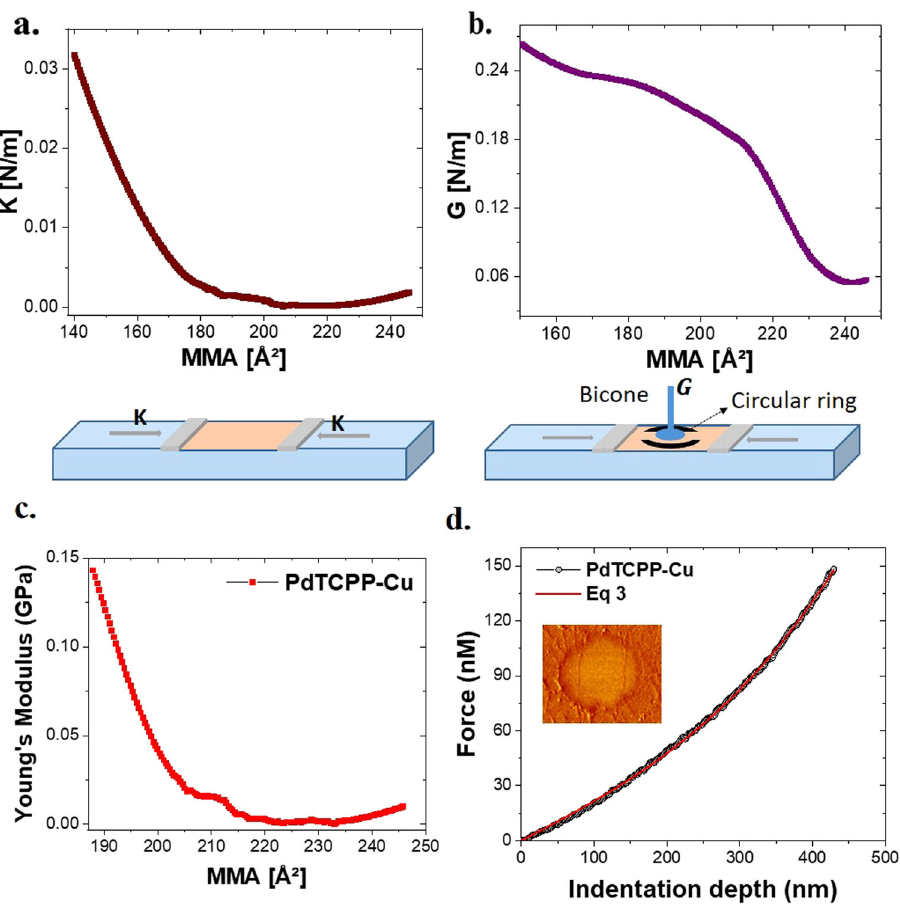
Fig. 3 Mechanical moduli determined by the Langmuir technique and nano-indentation. a The 2D compression modulus of the PdTCPP-Cu monolayer was obtained by measuring the π -MMA isotherm as the monolayer is compressed to a preset pressure. b The interfacial shear storage modulus G ’ was measured using a biconical disk rheometer positioned in the interface. c The Young ’ s modulus of the PdTCPP-Cu monolayer was calculated from G and K . d AFM nanoindentation-based loading/unloading force curve measured at the center of the freestanding 2D MOF sheet as shown in the inset and curve fi tting to Eq.